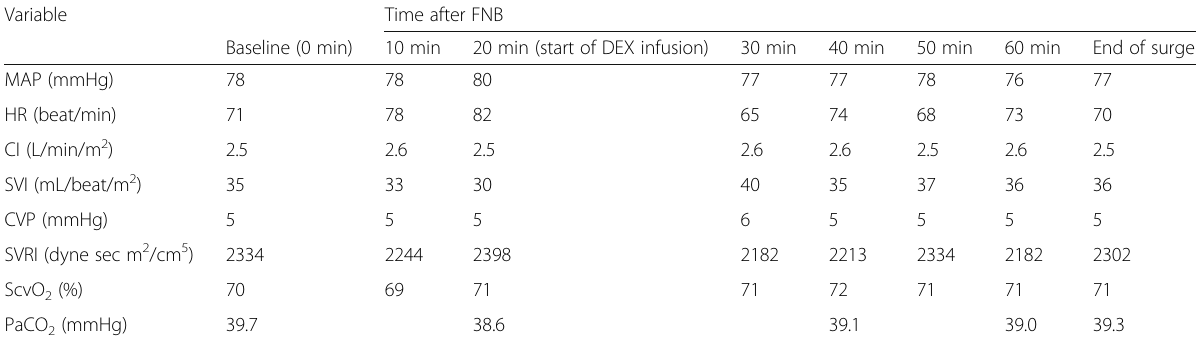
Table 1 Hemodynamic variables after FNB plus LFCNB